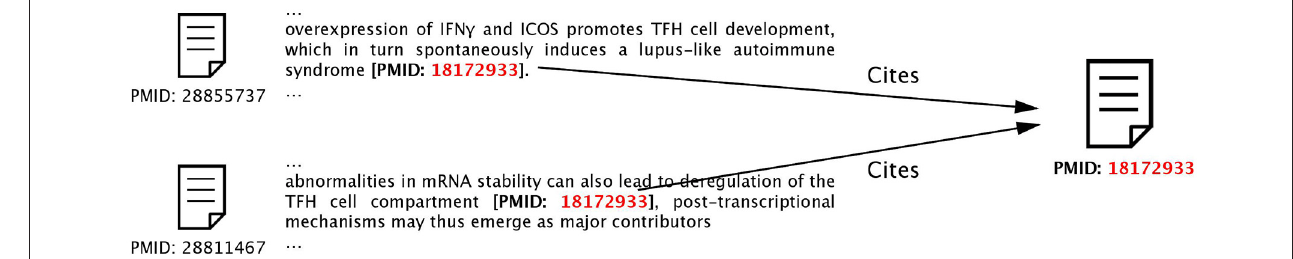
FIGURE 1 | Two examples of in-text citations and citation contexts of a PubMed article (PubMed ID: 18172933). This figure is a revised version from a workshop paper that was presented at CLBib-2017 (He and Chen,